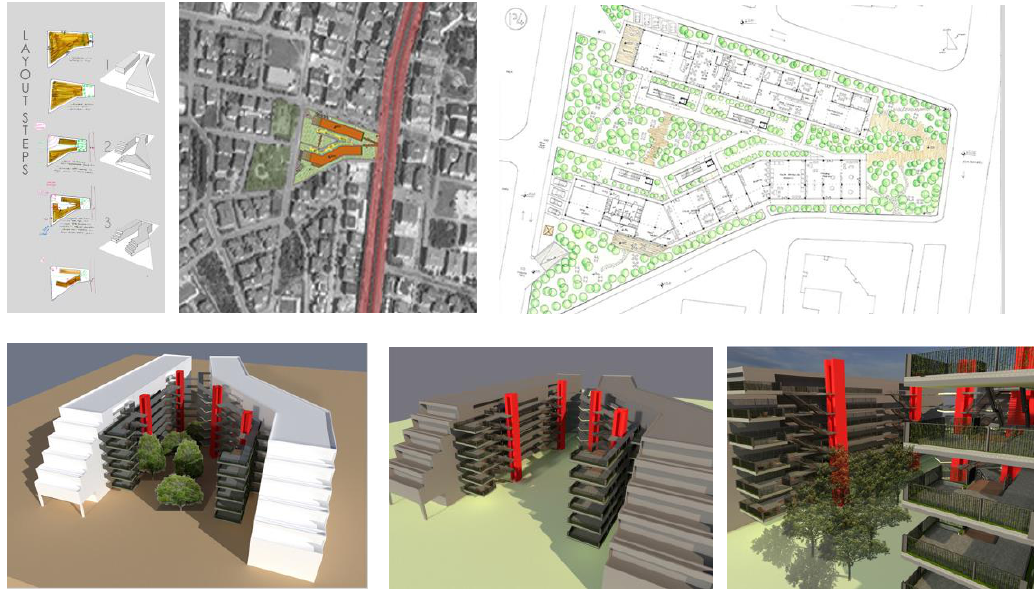
Figure 3. Zeynep Fazilet Kaya - GREEN